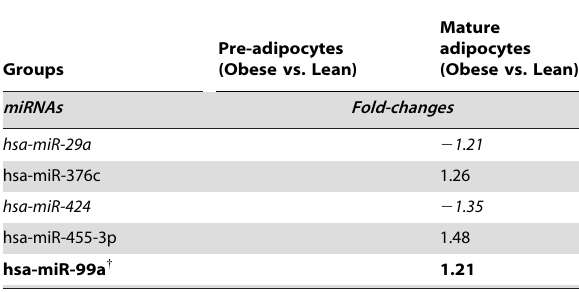
Table 1. Significant (p , 0.0001) fold-changes for miRNA expression in in vitro cultured pre-adipocytes and mature adipocytes between subcutaneous fat cells from obese (BMI . 30.0 Kg/m 2 ) and lean (BMI , 25.0 Kg/m 2 ) individuals.